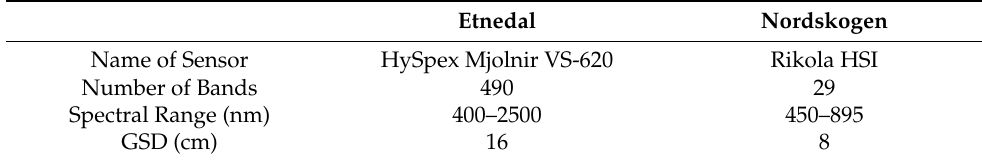
Table 1. Comparison of sensors used in the study.